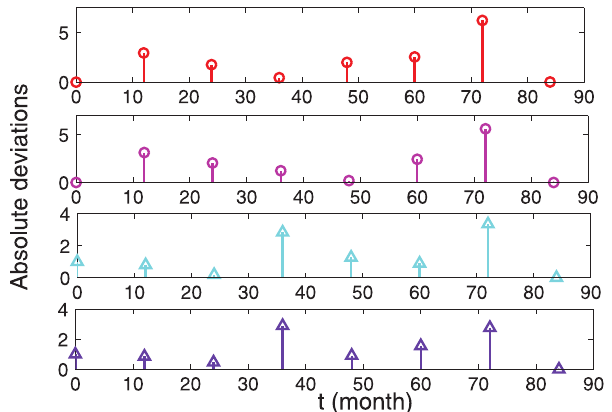
Figure 7. Deviations between experimental, analytical and numerical results for the NTM-infection case. Absolute difference between experimental data and theoretical data reported in Fig. 5; the same legend holds.